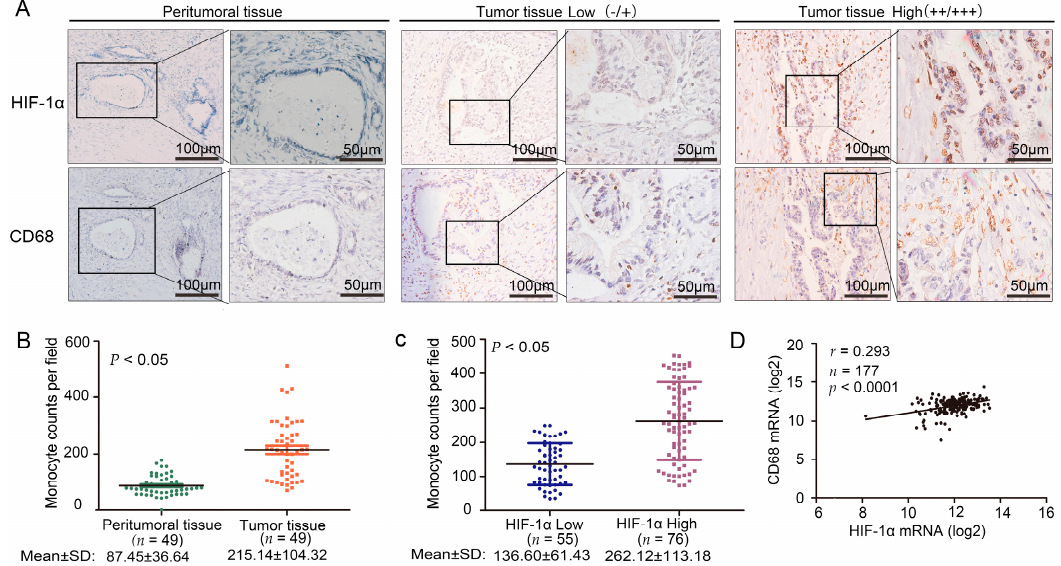
Figure 1. The correlation between hypoxia inducible factor (HIF)-1 α and CD68 expression in